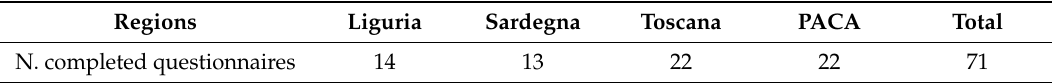
Table 1. Number of questionnaires completed and validated per